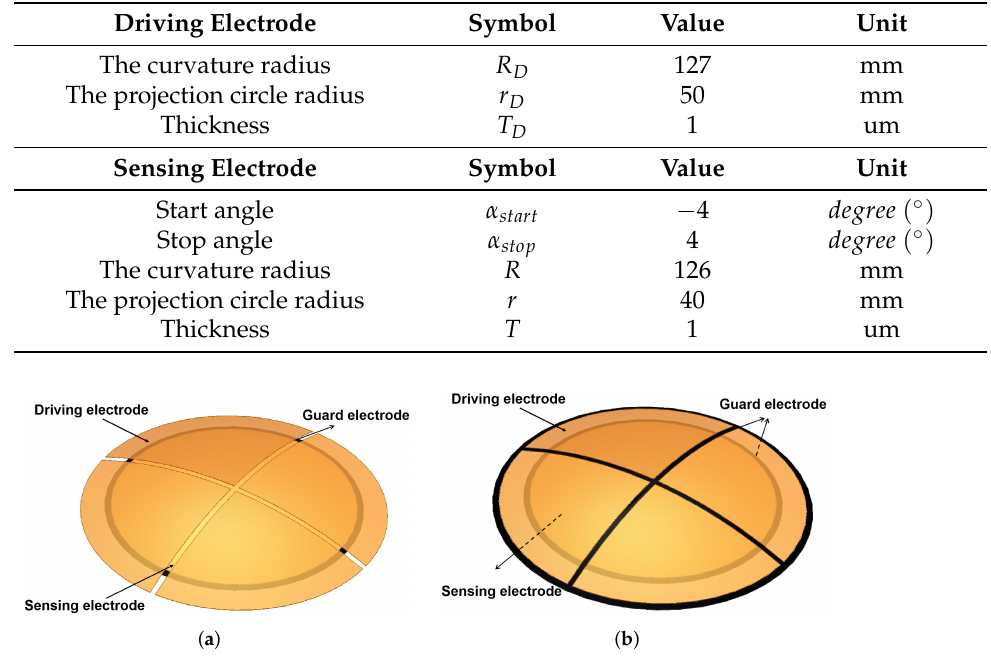
Figure 2. Simulation model of the capacitive sensor: ( a ) simulation Model 1 without shield electrode, ( b ) simulation Model 2 with a shield